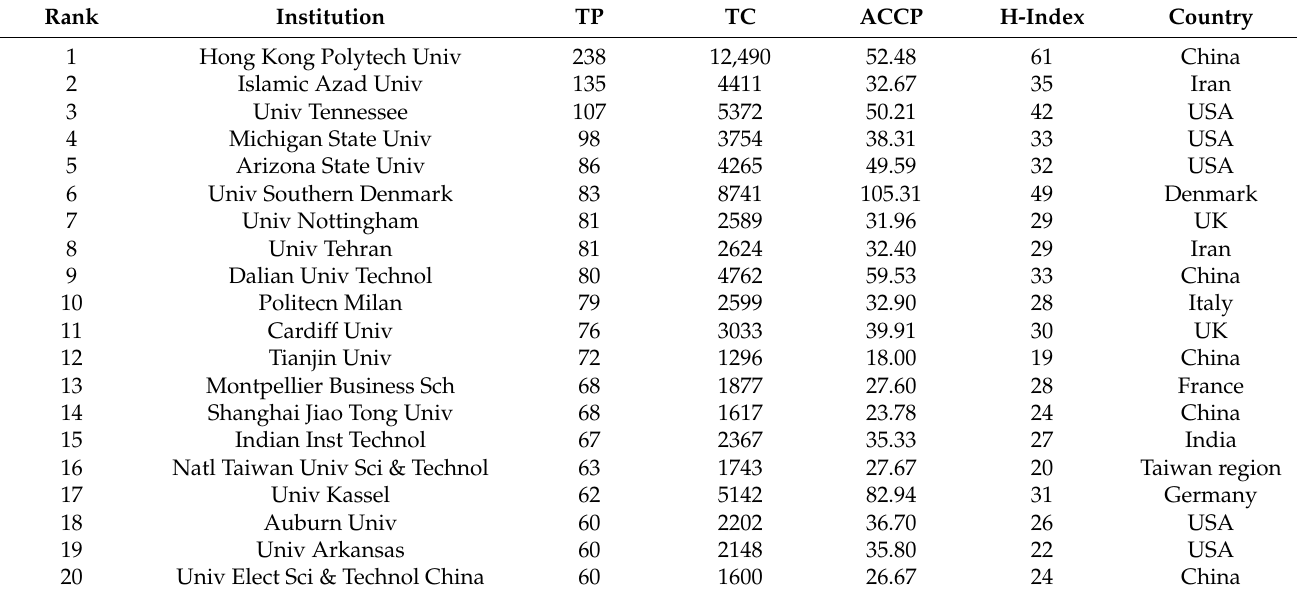
Table 4. The top 20 most productive institutions of publications during